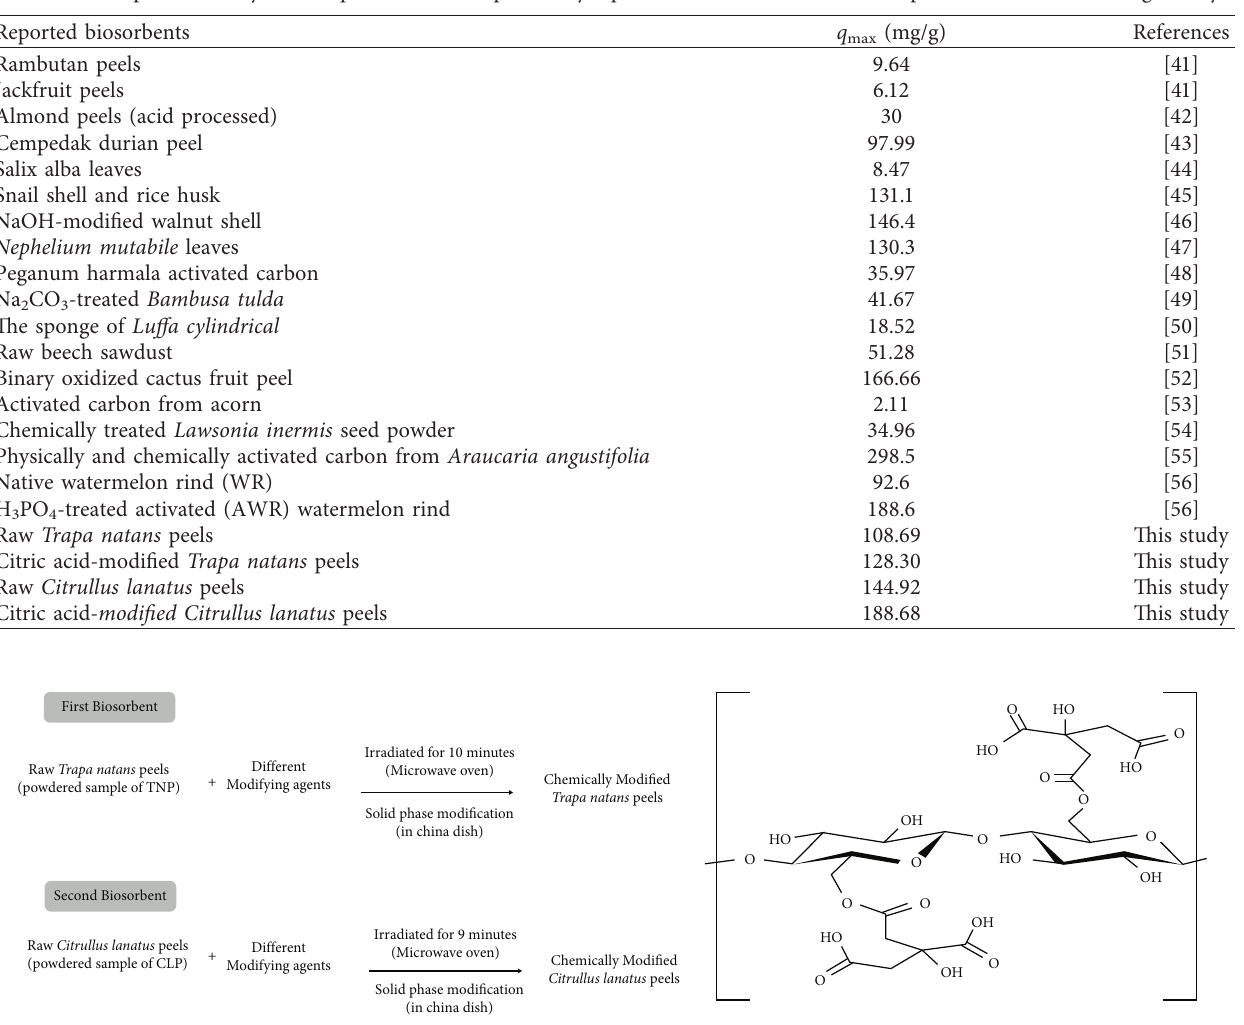
Table 1: A comparative study of adsorption with some previously reported biosorbents for the biosorptive removal of brilliant green dye. Reported biosorbents